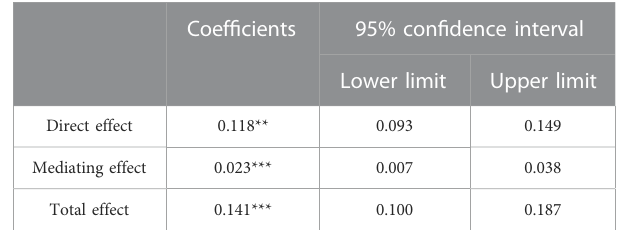
TABLE 5 Mediating effect test.